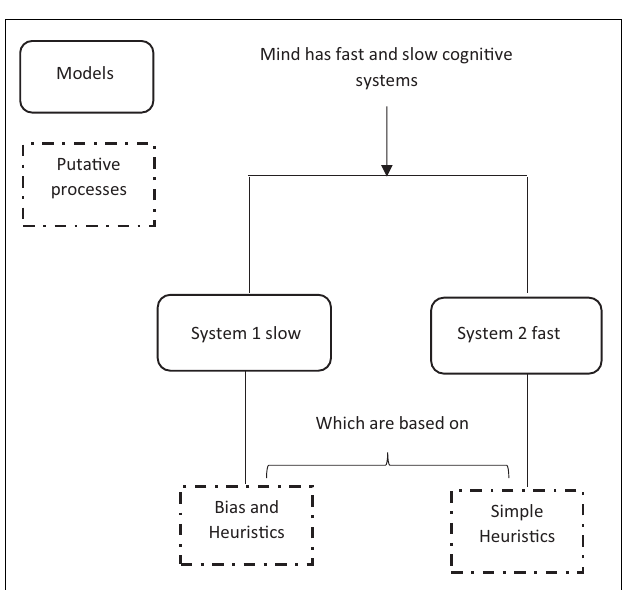
FIGURE 3 | A simplified schematic representation of the Kahneman’s two system framework cognition. Image has been redrawn and adapted from Tagliabue et al. (2019), open accesses, permission